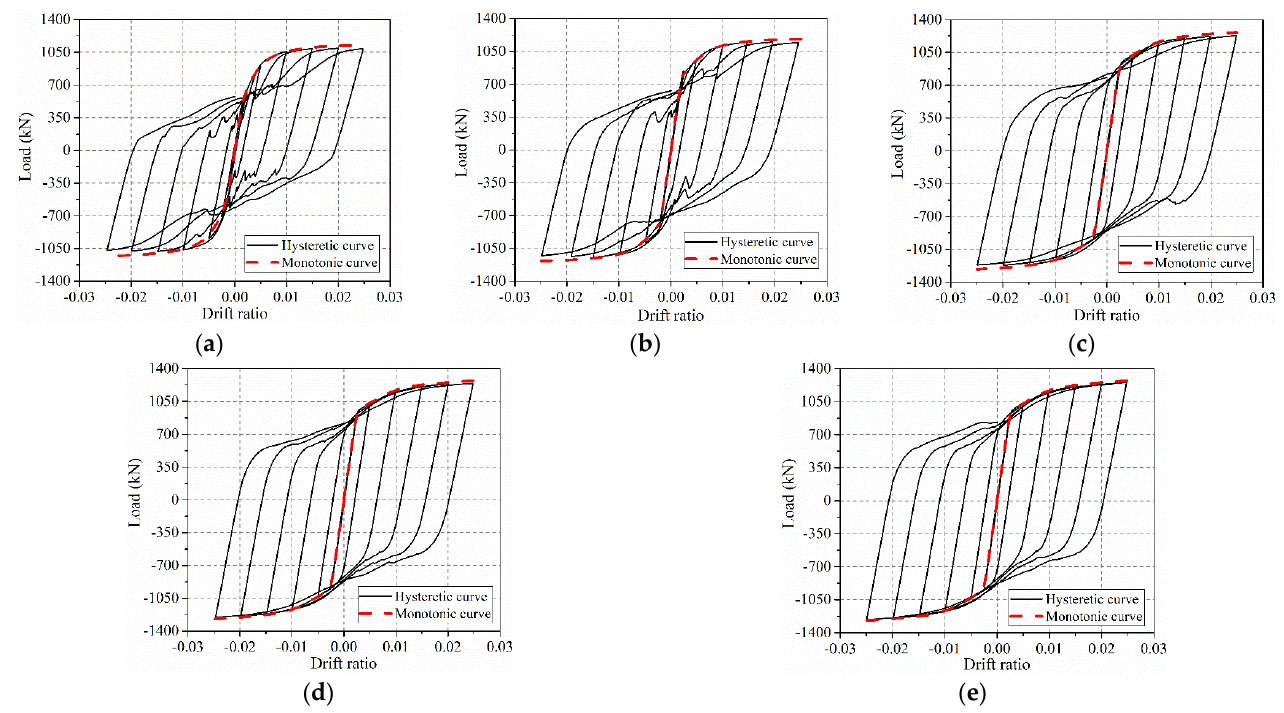
Figure 8. Hysteretic curves for SPSW1 − 1VHS with different η : ( a ) η = 0 (USPSW1); ( b ) η = 10; ( c ) η = 30; ( d ) η = 60; ( e ) η =90; ( f ) η = 120.